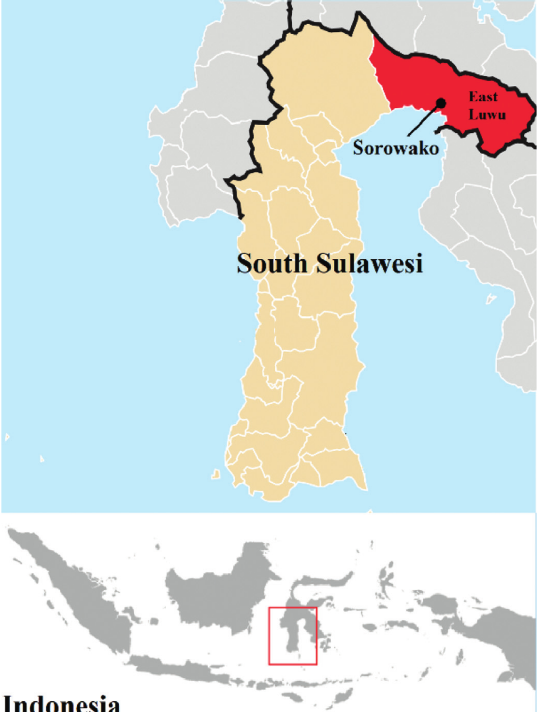
Figure 1: The location of soil sample collection at PT Vale Indonesia, Sorowako, East Luwu, South Sulawesi,